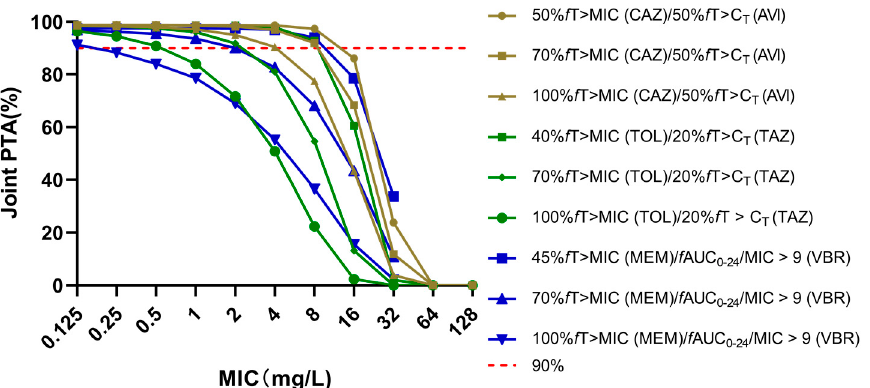
Figure 1. The joint PTA of different PK/PD indexes was achieved at a specific MIC for three novel BLBLIs standard regimens. Joint PTA: the product of the probability of target attainments of β -lactam and β -lactamase inhibitor; f T > MIC: the percentage of time during the dosing interval that free drug concentrations remain above minimal inhibitory concentrations; f T > C T : the percentage of time during the dosing interval that free drug concentrations remain above threshold concentration; f AUC 24 /MIC: the 24-h area under the free concentration-time curve divided by the minimum inhibitory concentration ratio; CAZ: ceftazidime; AVI: avibactam; TOL: ceftolozane; TAZ: